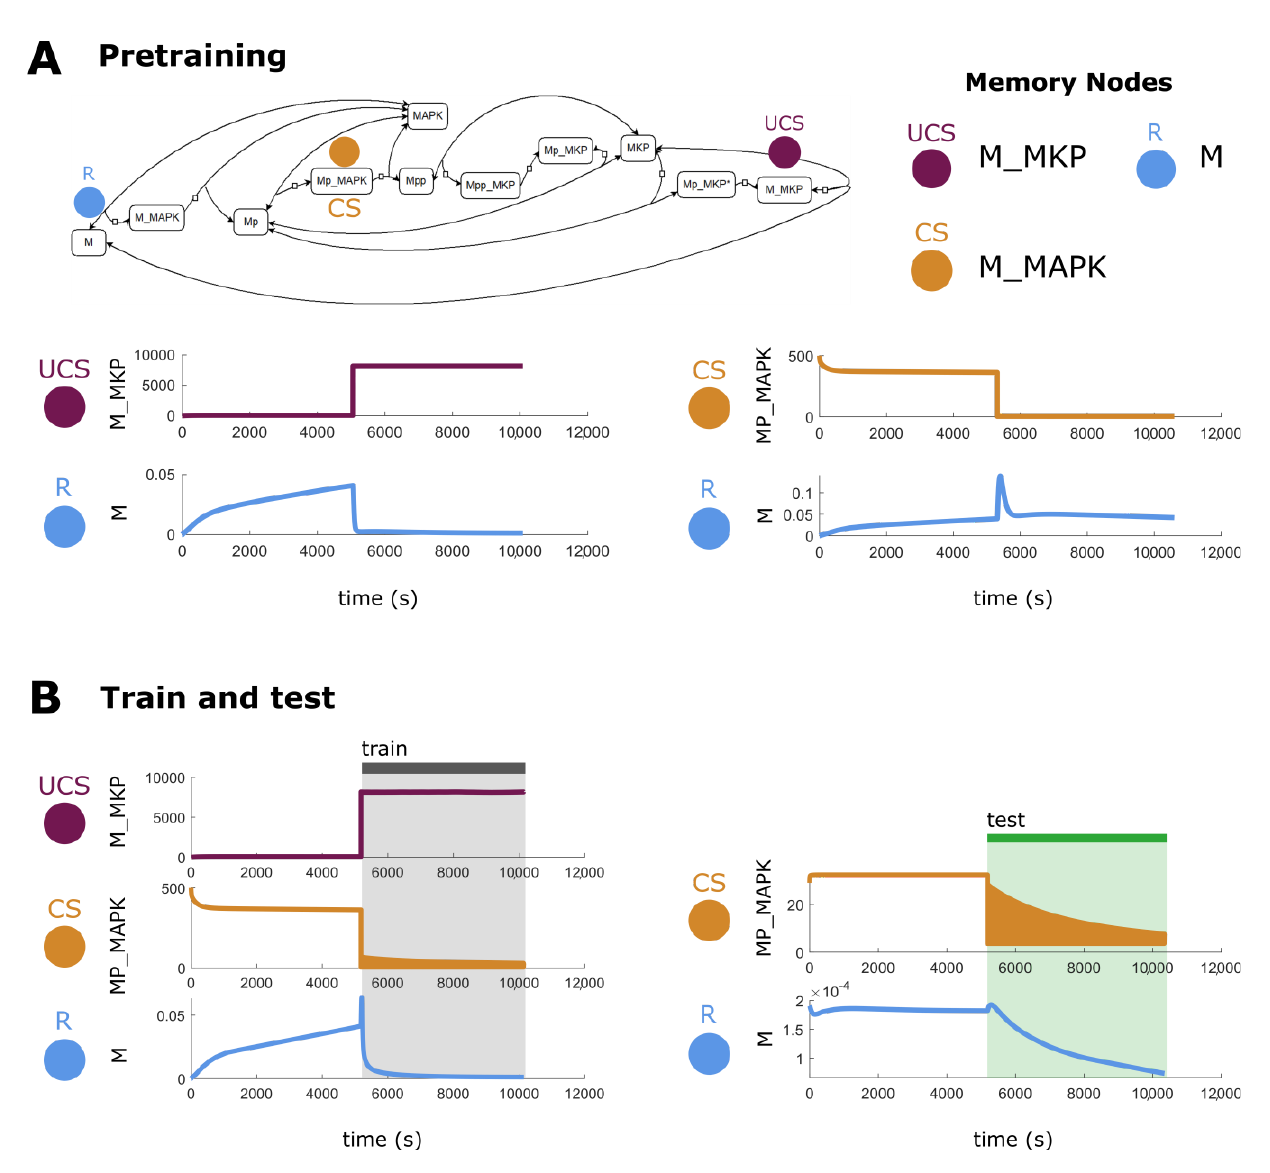
Figure 4. Associative memory in a biological network. ( A ) An example of associative memory in a potential memory model derived from a biological model from [75]. This particular memory model passes the pretest — UCS stimulation leads to change in R while a stimulation of CS does not. ( B ) To train the model towards a response in R from a stimulation in CS, the UCS and CS are stimulated at the same time, upregulated and downregulated, respectively. After, the circuit is tested and now stimulation of the CS (downregulation) causes lasting change in R. The colors under the yellow line in both training and testing periods are meaningless and are artifacts due to the integrator